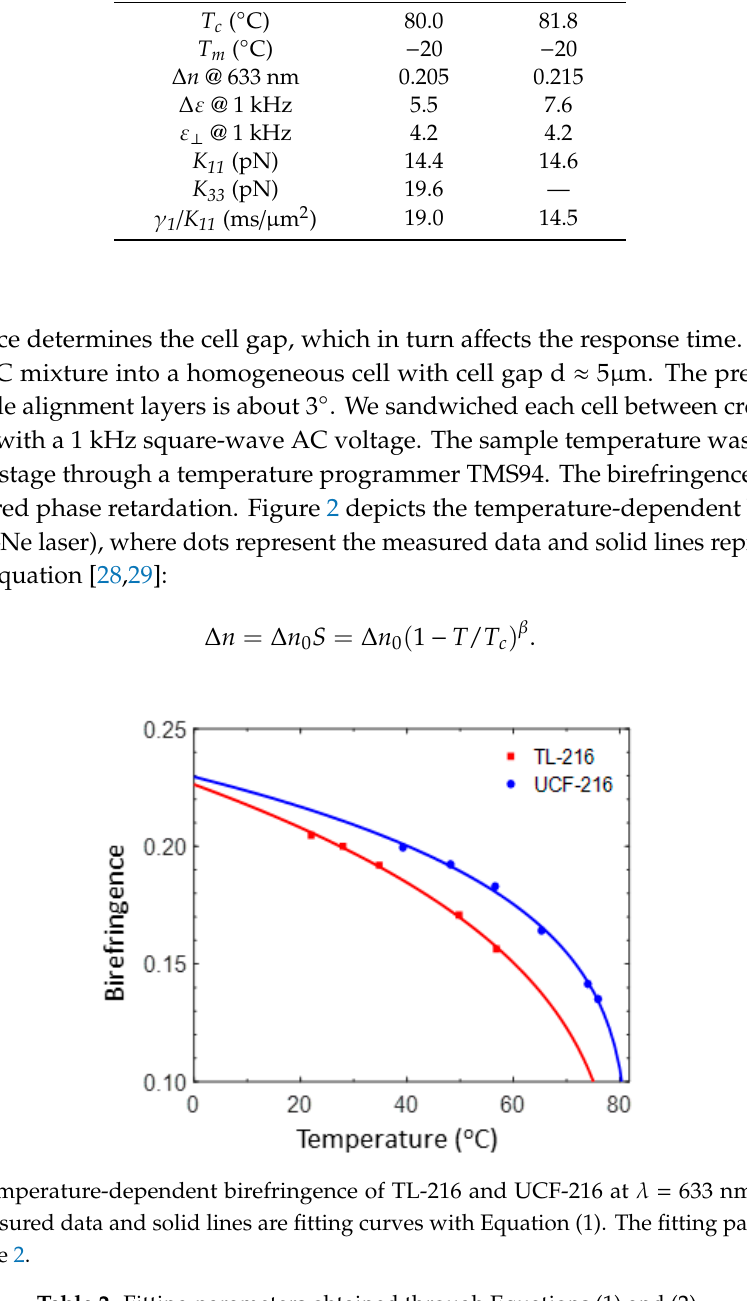
Table 1. Measured physical properties of TL ‐ 216 and UCF ‐ 216 at T = 22 °C.